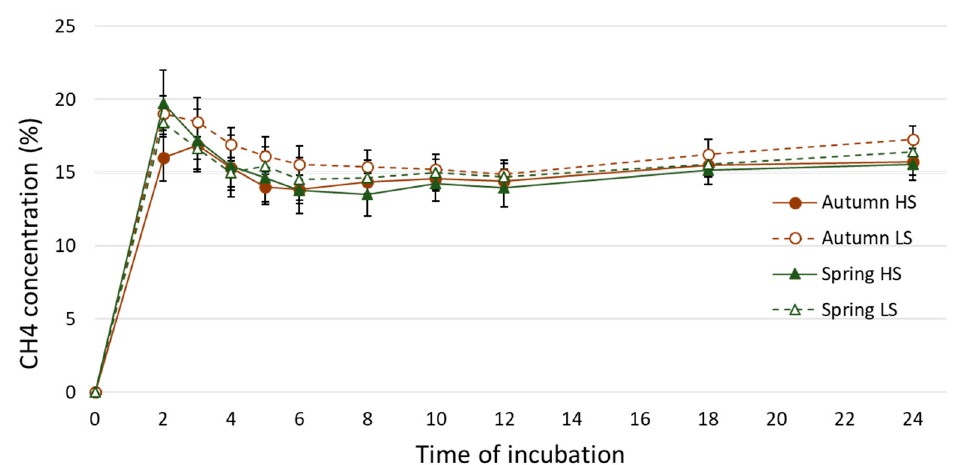
Figure 2. Methane (CH 4 ) proportion of total gas production throughout the 24 h of in vitro incubation. HS: high sugar pasture; LS: standard cultivar pasture.